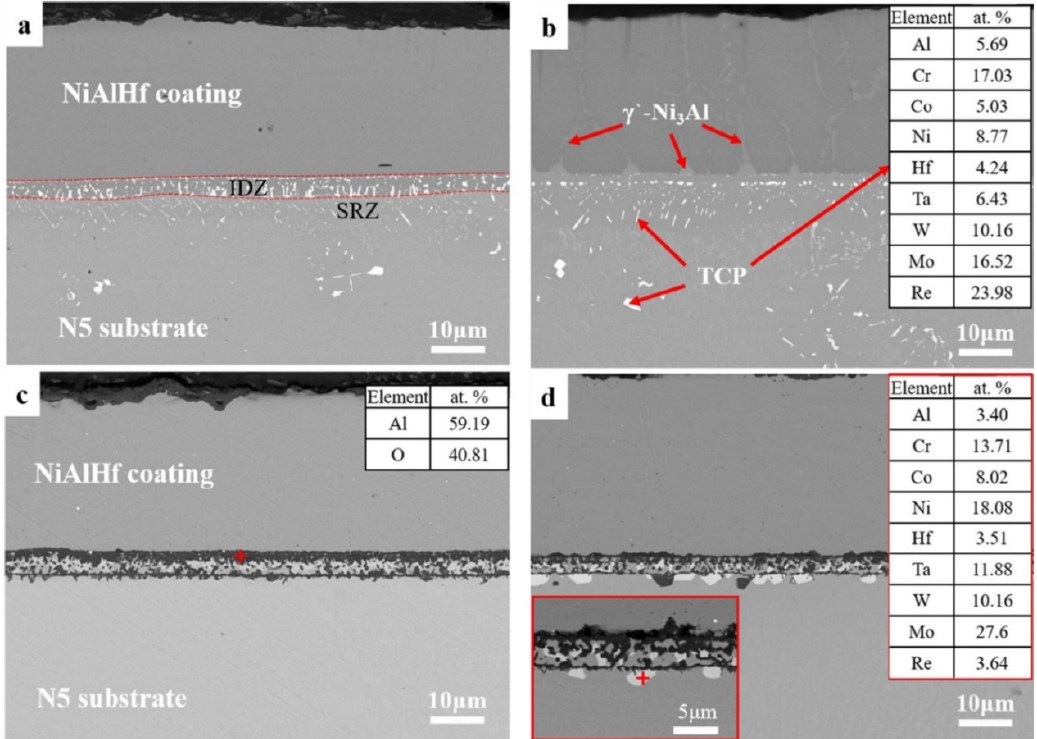
Figure 20. Specimen’s cross-sectional morphologies after static isothermal oxidation at 1100 °C (Specimen NN after ( a ) 50 h and ( b ) 100 h oxidation, Specimen NHN after ( c ) 50 h and ( d ) 100 h oxidation). Insets of EDS of precipitates in NN and NHN specimens after 100 h oxidation. Reprinted with permission from [160] Copyright 2021 Elsevier.